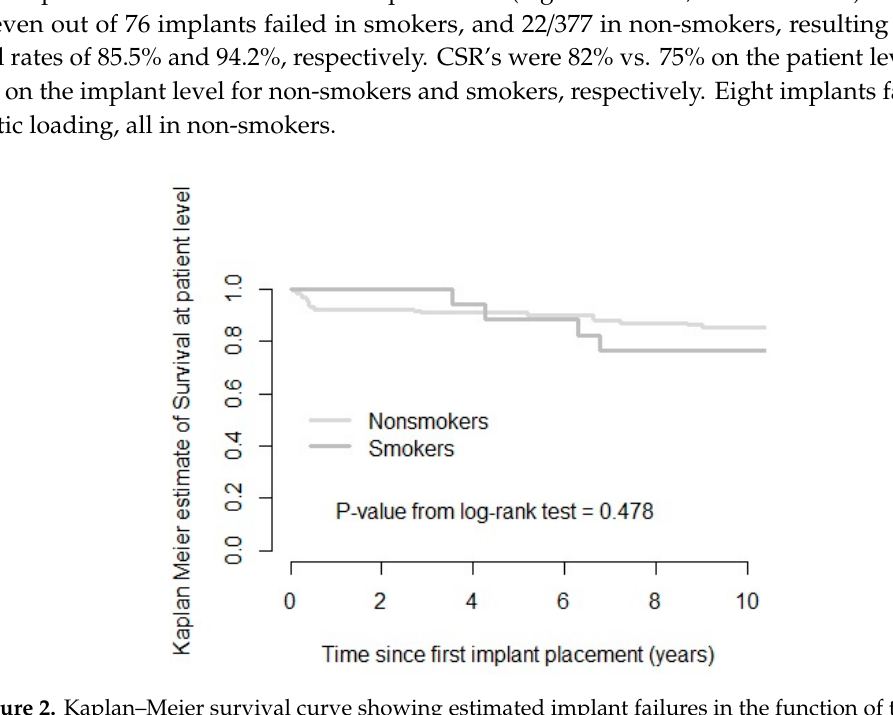
Figure 2. Kaplan–Meier survival curve showing estimated implant failures in the function of time for smokers and non-smokers on the patient level.